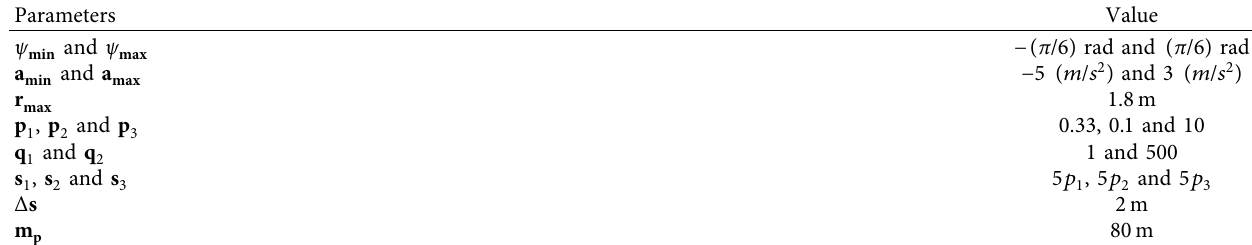
Figure 4: Illustration of road trajectory. Table 2: Default parameters for model validation.